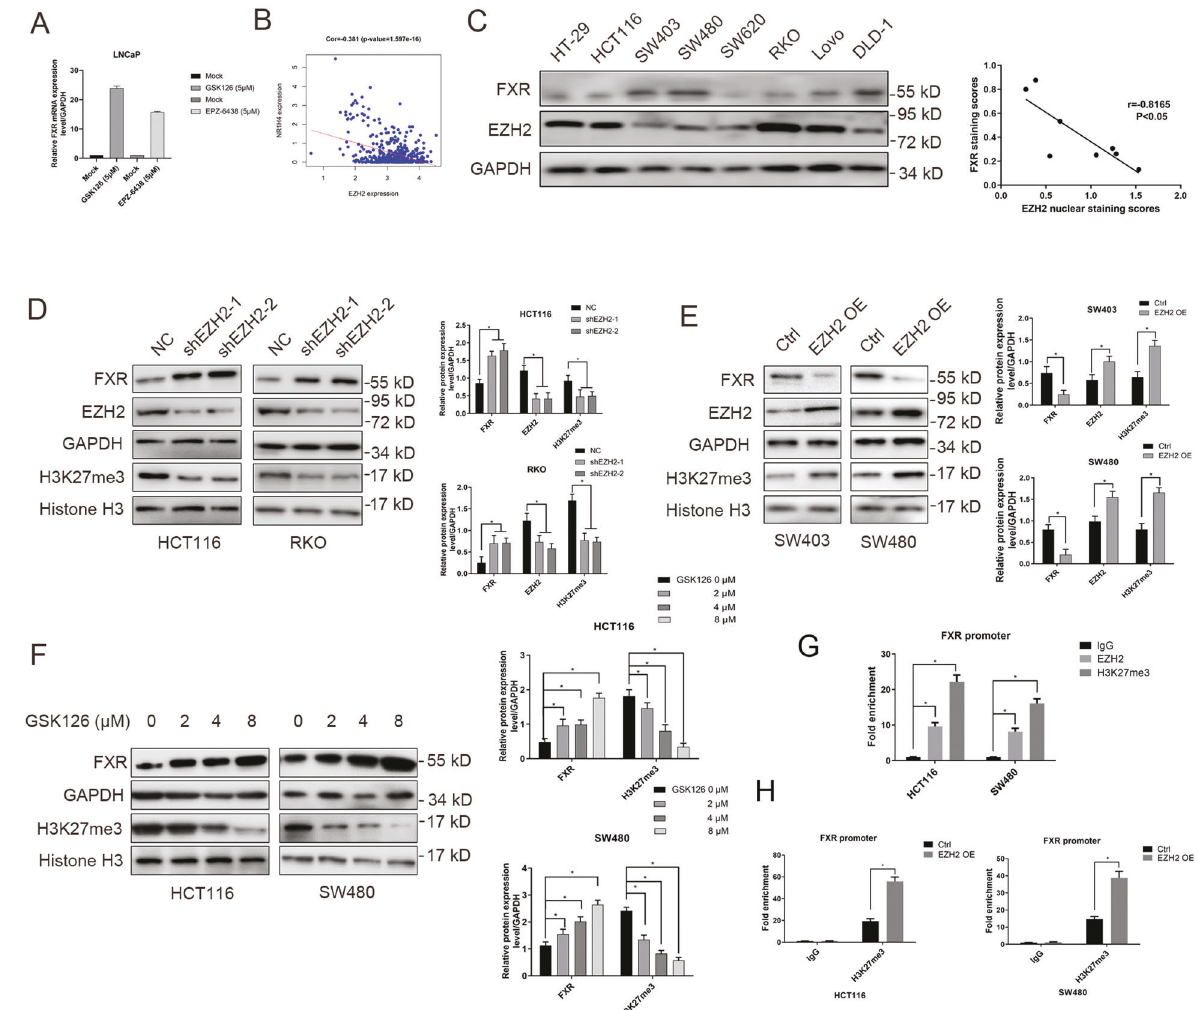
Fig. 1 EZH2 negatively regulated the expression of FXR by H3K27me3. a Relative NR1H4 mRNA levels in LNCaP cells treated or not with GSK126. b Correlation analysis of EZH2 and FXR mRNA level in colon cancer tissues from TCGA database. c The protein levels of EZH2 and FXR in colon cancer cells by western blotting analysis (left panel: gel bands; right panel: correlation analysis between EZH2 and FXR). d The protein levels of FXR and H3K27me3 in HCT116 and RKO cells with EZH2 depletion by western blotting analysis (left panel: gel bands; right panel: quantitative analysis of these proteins). e The protein levels of FXR and H3K27me3 in SW403 and SW480 cells with EZH2 overexpression by western blotting analysis (left panel: gel bands; right panel: quantitative analysis of these proteins). f The effect of EZH2 inhibitor GSK126 on the protein levels of FXR and H3K27me3 in SW403 and SW480 cells by western blotting analysis (left panel: gel bands; right panel: quantitative analysis of these proteins). g The ChIP analysis of the enrichment of H3K27me3 and EZH2 in the FXR promoter region. h The effect